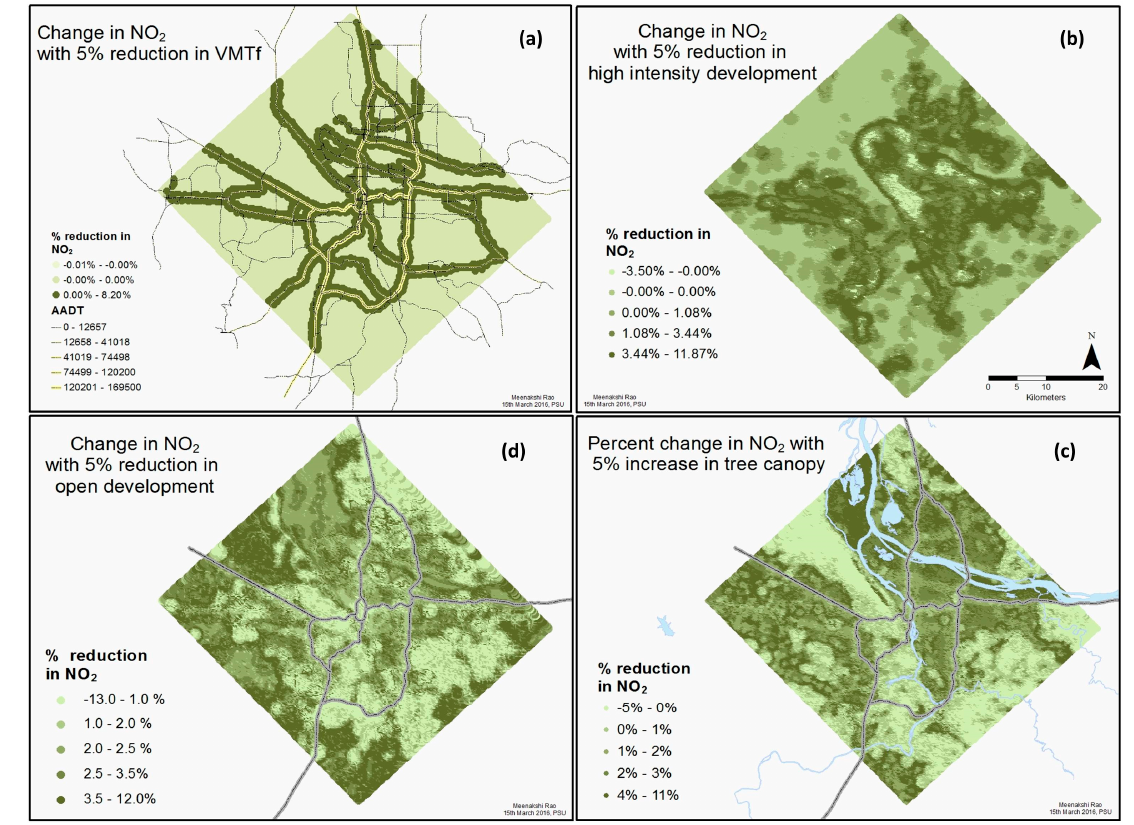
Figure 5. The spatial distribution and magnitude of the change in modeled NO 2 concentrations in response to a ±5% change in (clockwise from top left) ( a ) VMT f ( b ) high intentsity development ( c ) tree canopy ( d ) open development.